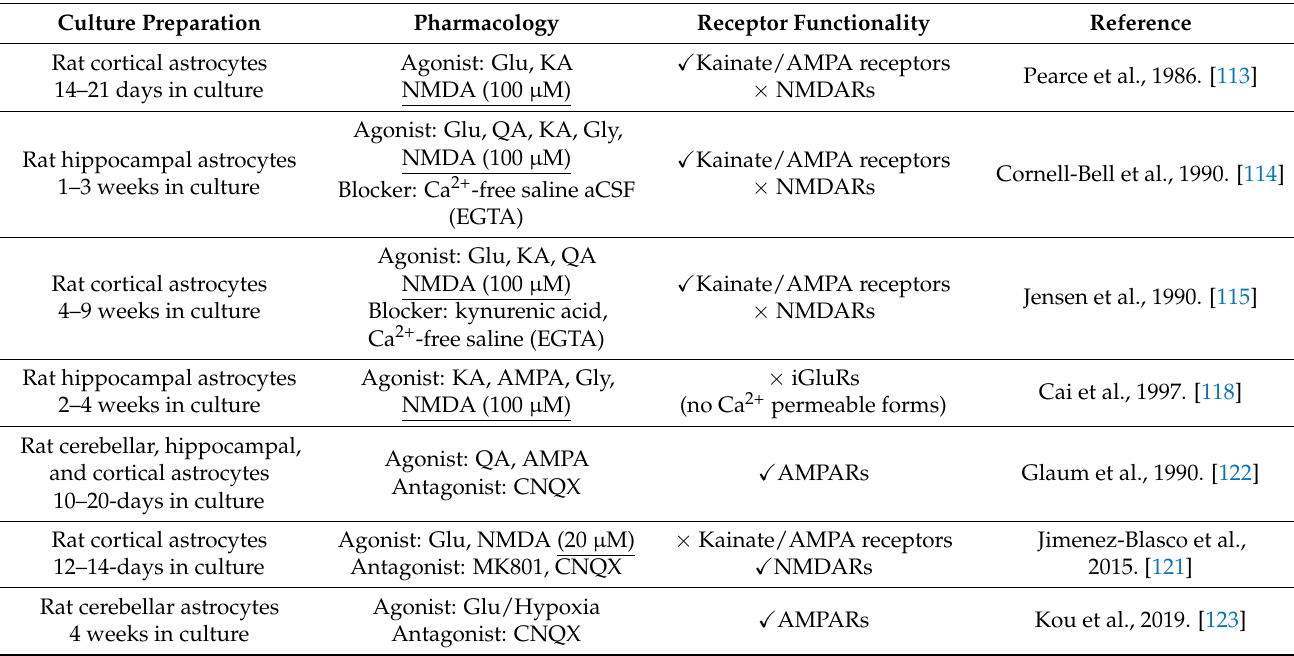
Table 1. Evidence of astrocyte iGluR-mediated Ca 2+ activity from Ca 2+ imaging in cell culture studies. The concentration of NMDA is noted when over (100 µ M) or under (20 µ M) the toxic concentration (50 µ M). (cid:88) and × show the presence or absence of function receptors in each study. Agonists: Glutamate (Glu), kainate (KA), quisqualate (QA), Glycine (Gly), N -methyl-D-aspartate (NMDA), α -amino-3-hydroxy-5-methyl-4-isoxazolepropionic acid (AMPA). Culture Preparation Pharmacology Receptor Functionality